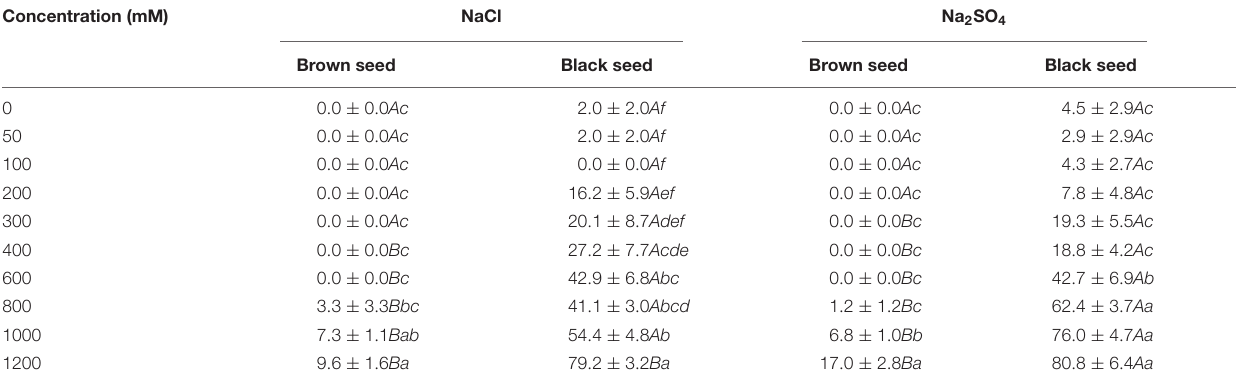
TABLE 3 | Recovery percentage of dimorphic seeds of S. salsa in deionized water after NaCl or Na 2 SO 4 pretreatment. Concentration (mM)